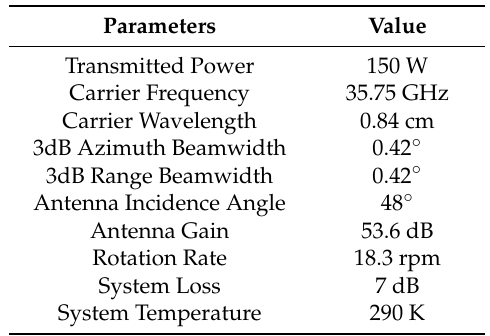
Table 8. Main parameters of the Ka-band DopScat.